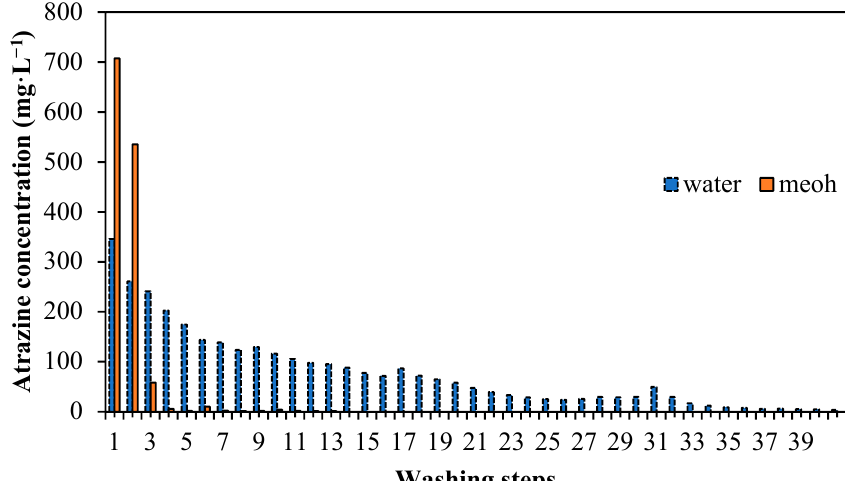
Figure 3. Washing steps in different Figure 3 Washing steps in different solvent.